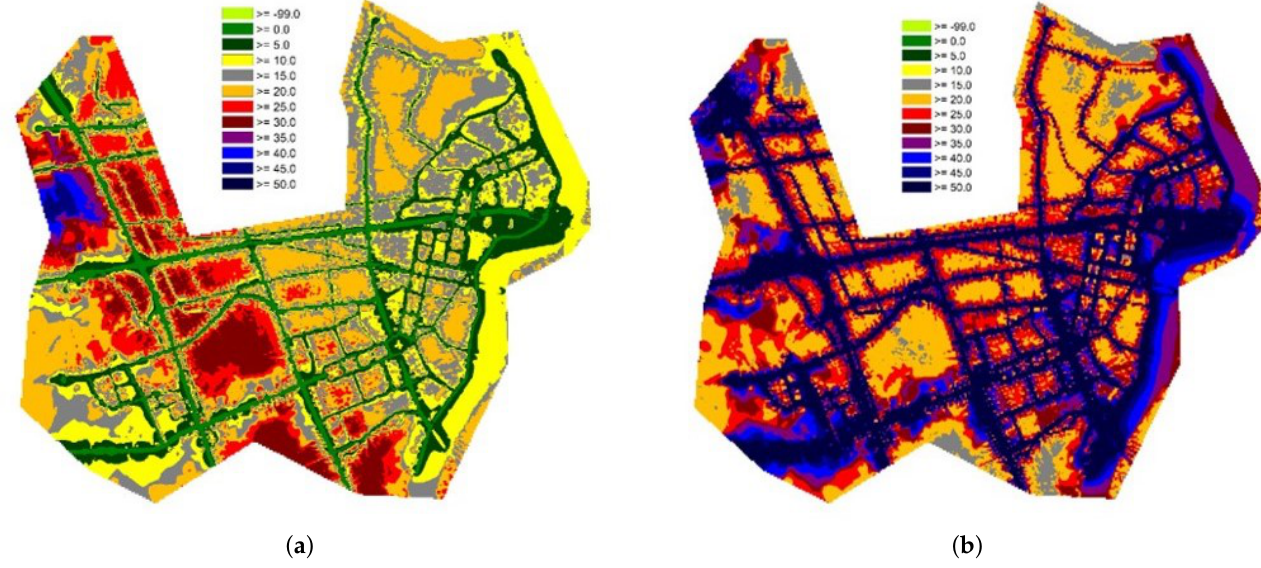
Figure 12. Annoyance maps: ( a ) Aircraft Noise with road traffic noise as background sound; ( b ) Road Traffic Noise with aircraft noise as background